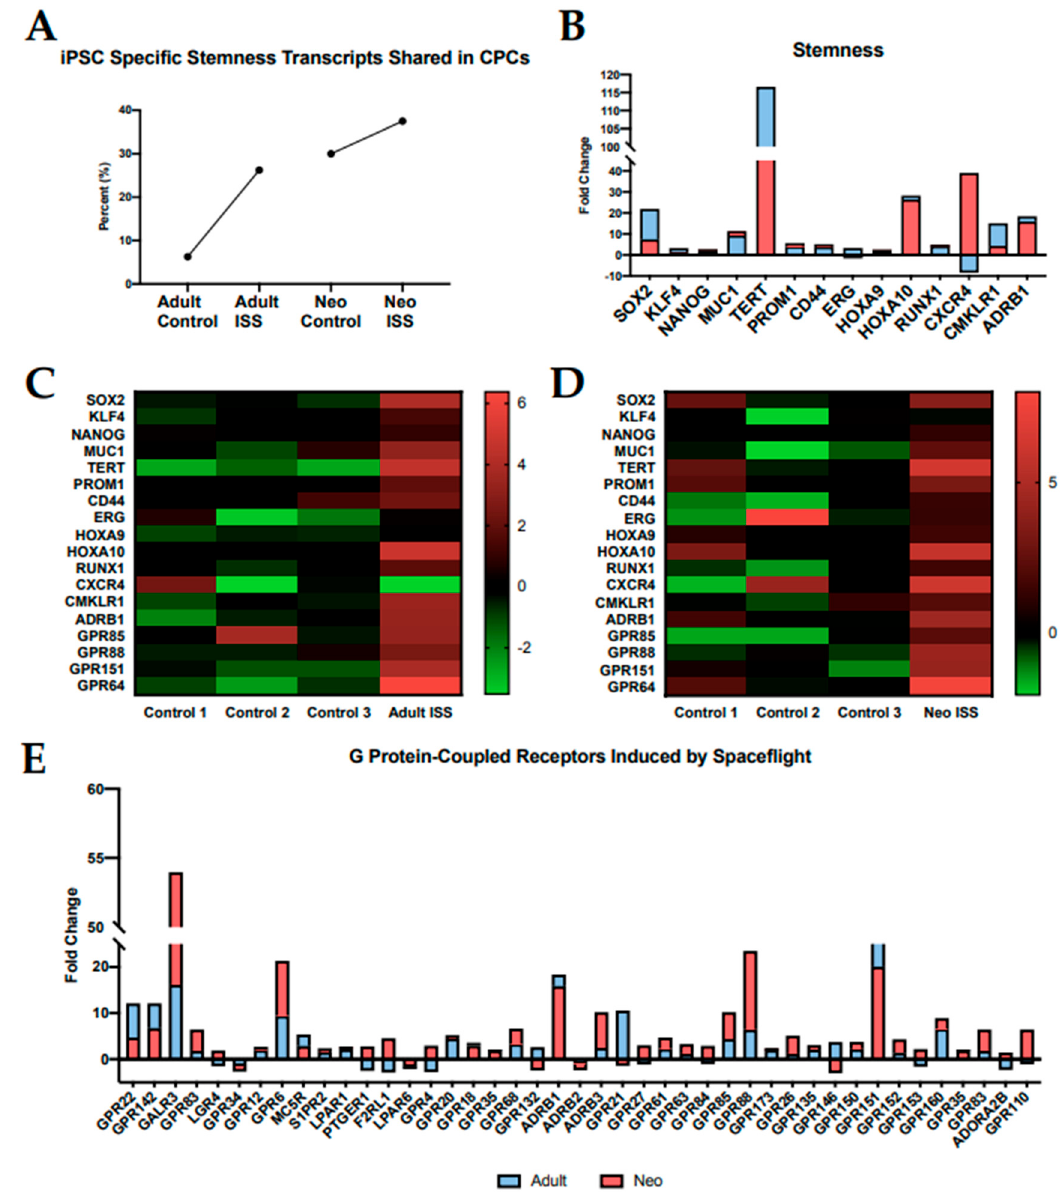
Figure 2. Spaceflight induces transcripts related to stemness. ( A ) StemChecker shows an increase in overlapping iPSC stemness markers in flown CPCs. ( B ) Other established stemness markers were impacted by spaceflight. ( C ) Differential gene expression in flown samples and ground controls in adult CPCs and ( D ) neonatal CPCs. ( E ) GPCR signaling was induced in CPCs cultured aboard the ISS. Individual fold changes for adult and neonatal groups are presented superimposed for comparison.